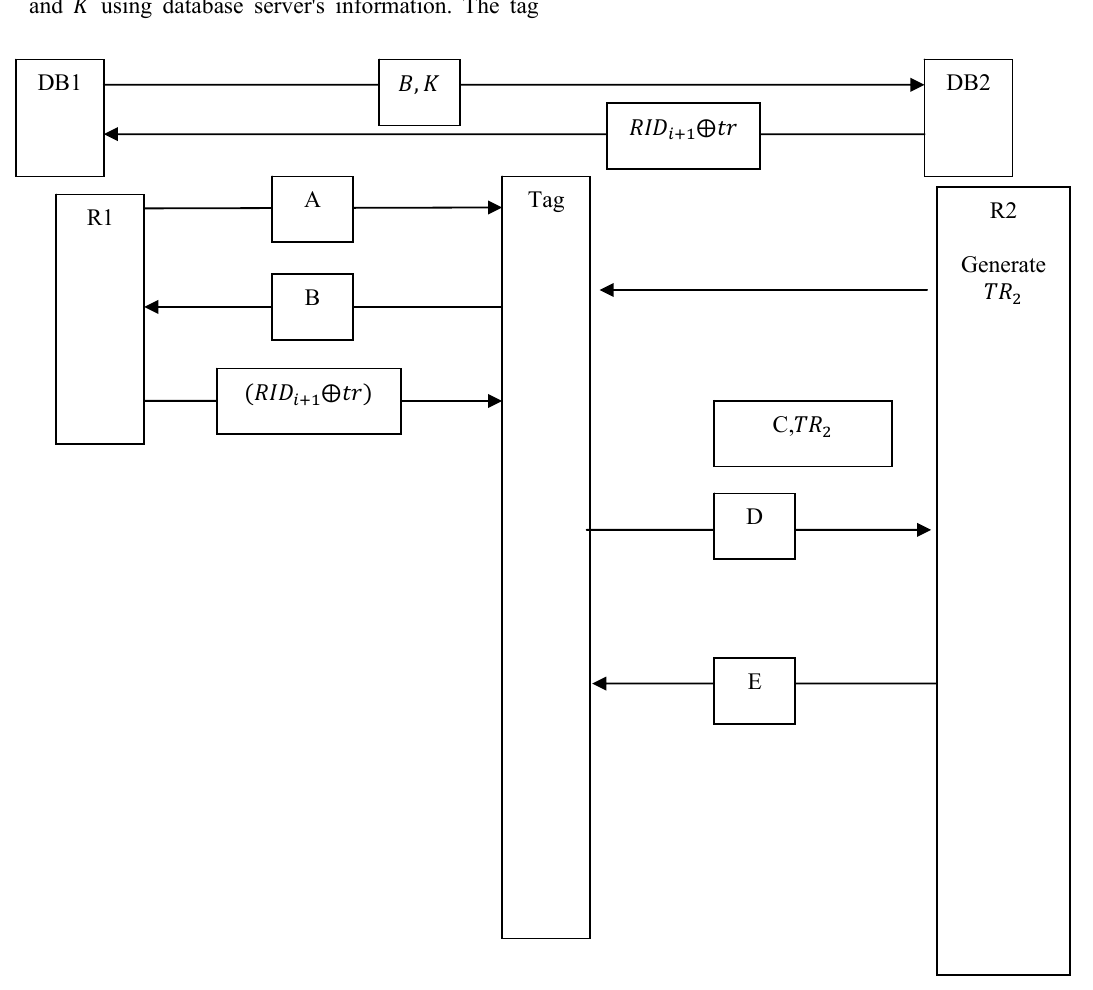
Figure 2: Details of the protocol scenario 1(2